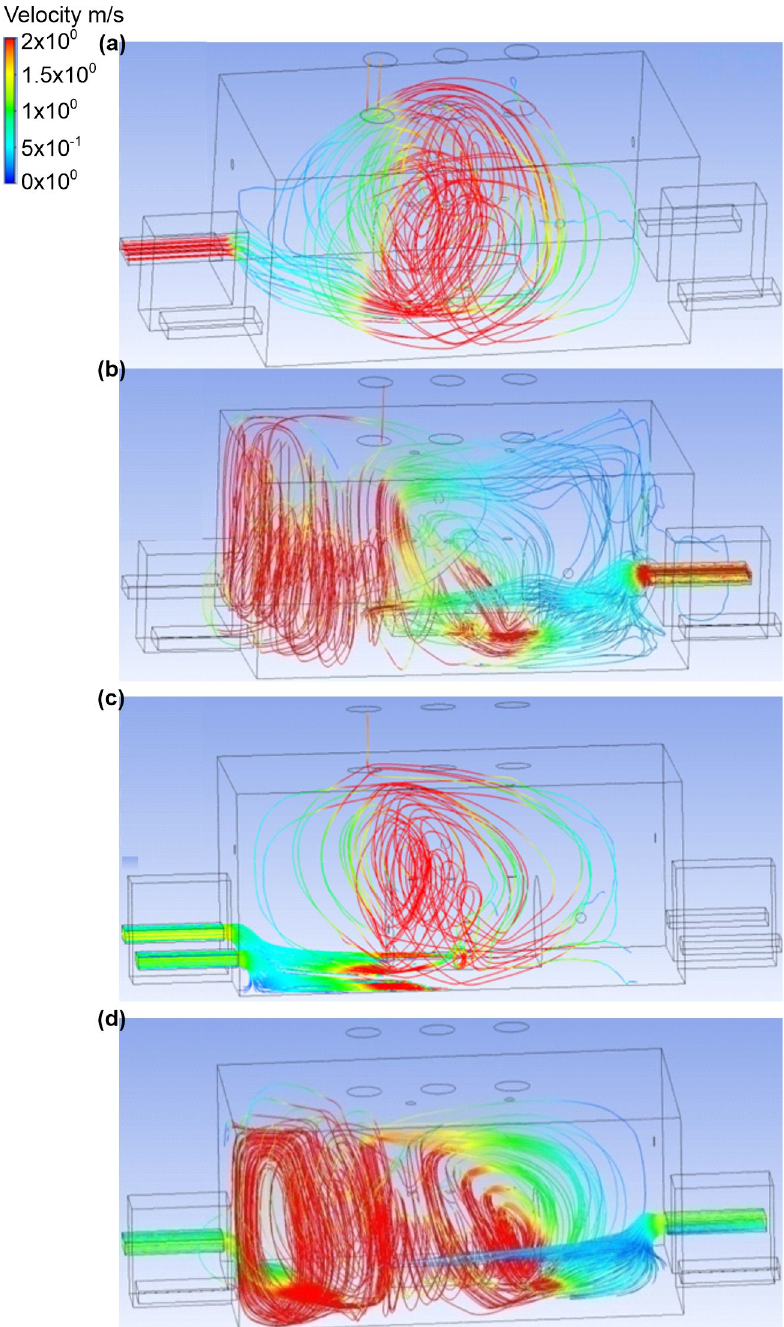
Figure 7. Velocity distribution in the engine room for: ( a ) scenario A, ( b ) scenario B, ( c ) scenario C, and ( d ) scenario D.